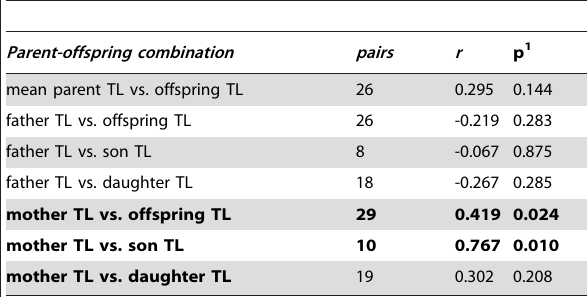
Table 1. Parent-offspring correlations of kakapo telomere length.